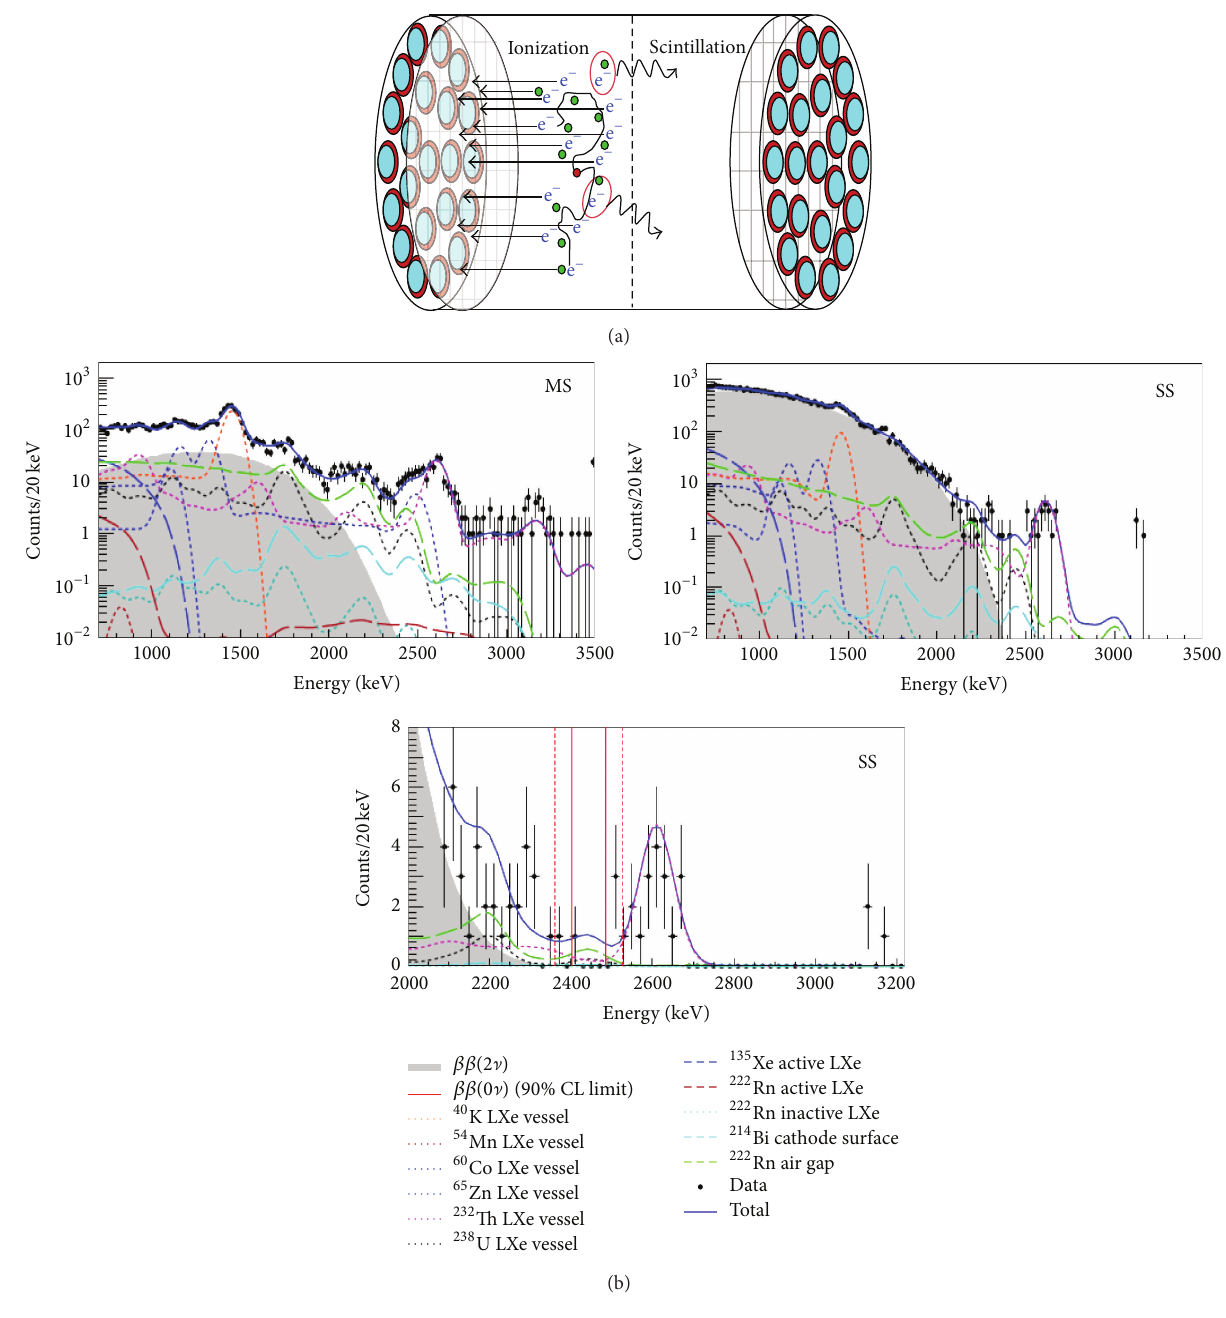
Figure 7: (a) EXO detector concept (figure from D. Auty presentation at 48th Rencontres de Moriond, year 2013). (b) EXO-200 results. The two plots at top show the MS (left) and SS (right) fits (see text for explanation), the plot at bottom is a zoom of the SS fit in the 𝛽𝛽(0 ] ) region (figure from